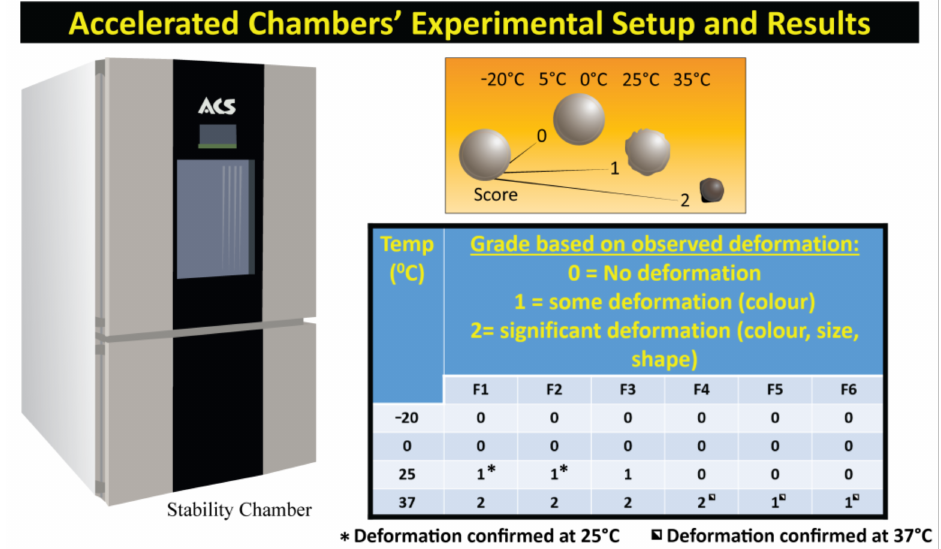
Figure 3. Accelerated stability testing setup, deformation key and